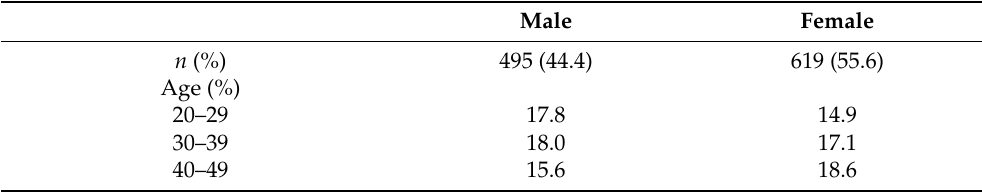
Table 1. Demographic characteristics in the Chinese adult